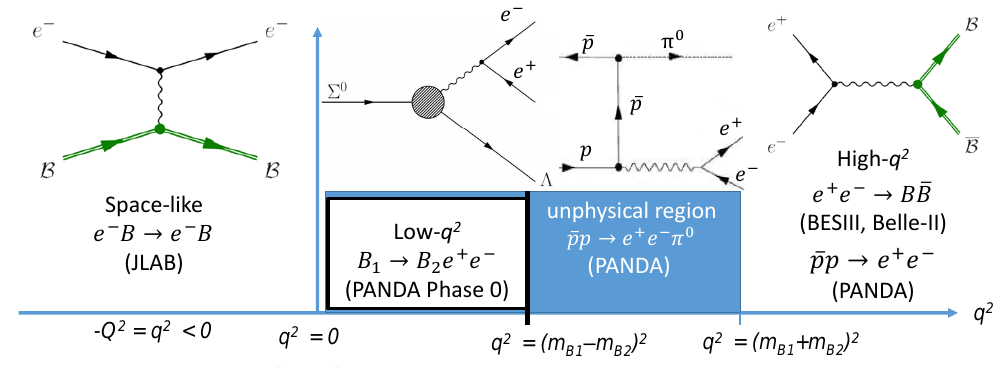
Figure 3: Processes for extracting EMFF in the space-like (left) and time-like (right) region. The low- q 2 (4 m 2 by Dalitz decays, the unphysical region (4 m 2 and the high- q 2 region ( q 2 > ( M